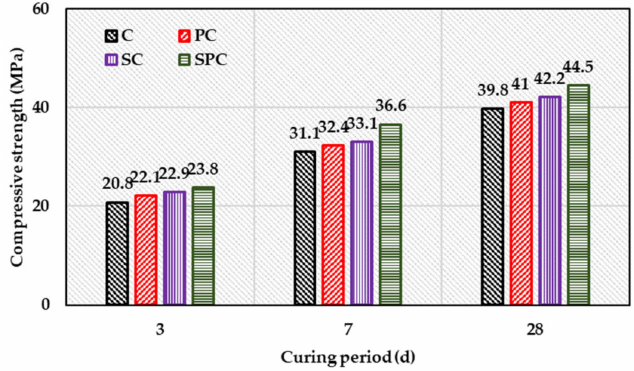
Figure 10. Compressive strength test results of impermeable